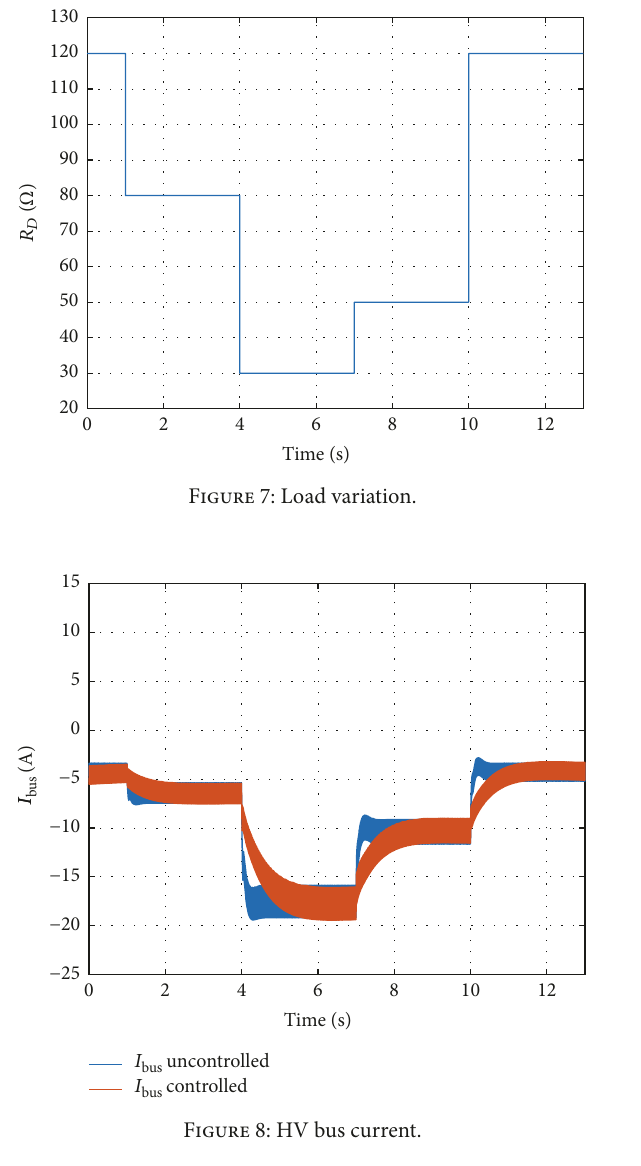
Figure 8: HV bus current.